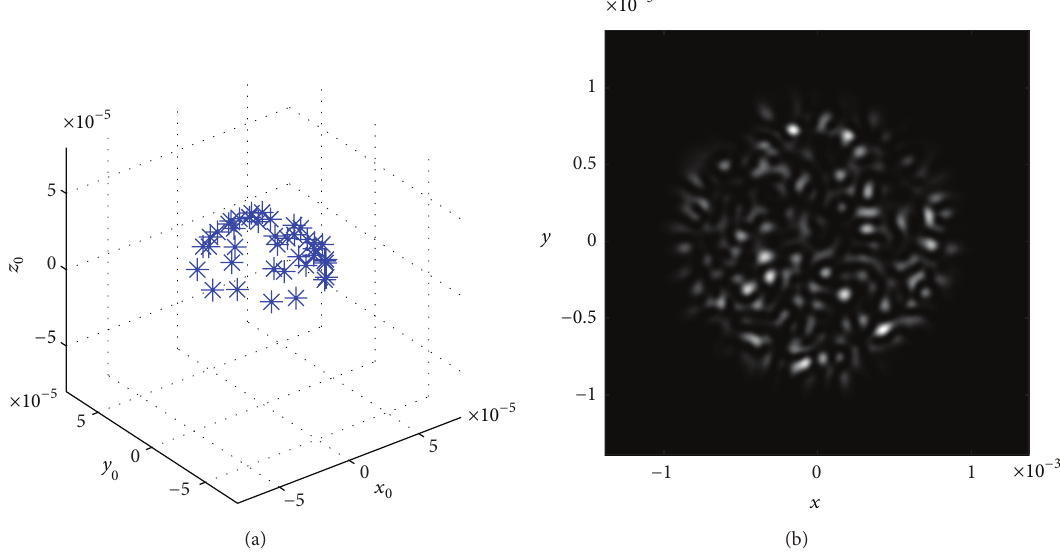
Figure 4: Half sphere composed of 40 randomly located Dirac emitters (a) and interferometric out-of-focus image created by this object (b). The radius of the half sphere is 40 micrometers. All axes are in